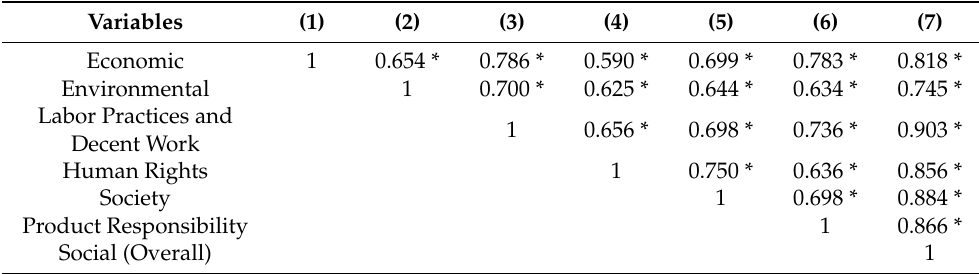
Table 10. Correlation between the economic, environmental, and social performance indicator